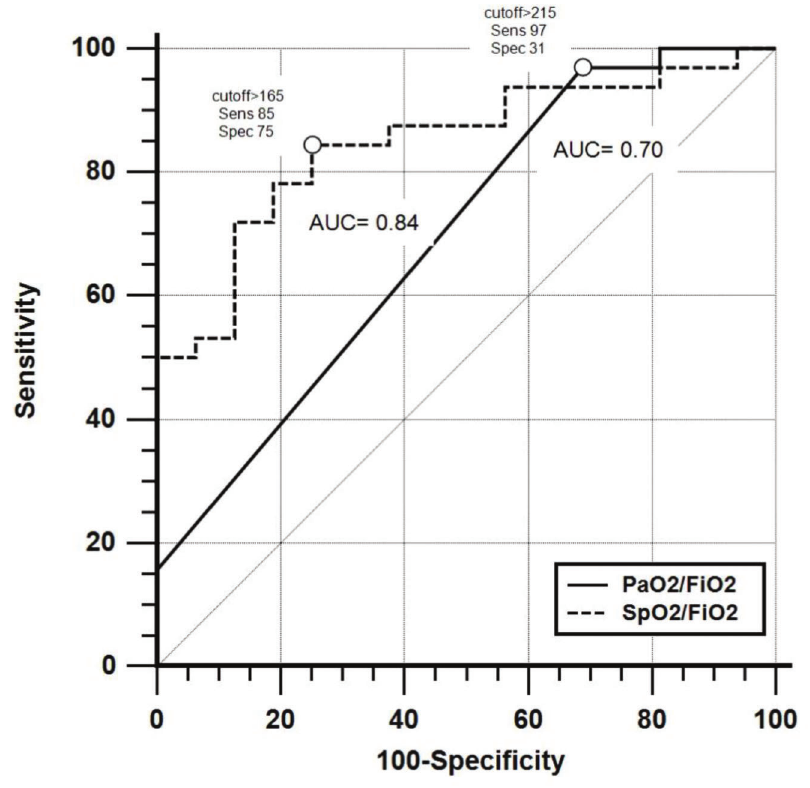
Figure 3 - SpO 2 /FiO 2 and PaO 2 /FiO 2 ROC curves for predicting the need for endotracheal